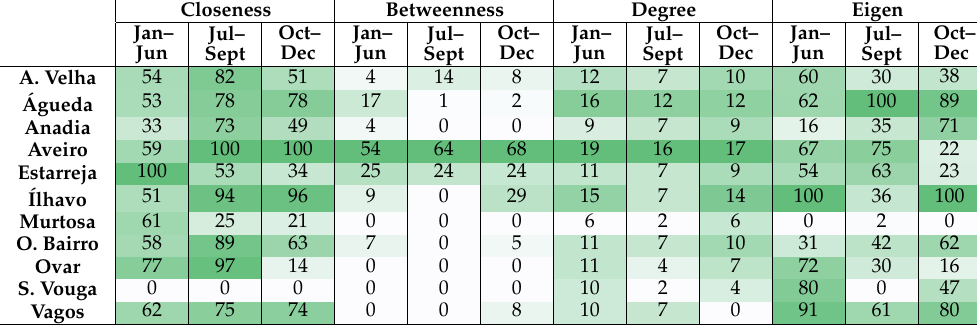
Table 4. Centrality Measures of the digraph related to the municipality data of Jan–Jun, Jul–Sept and Oct–Dec time intervals of 2021. Closeness Betweenness